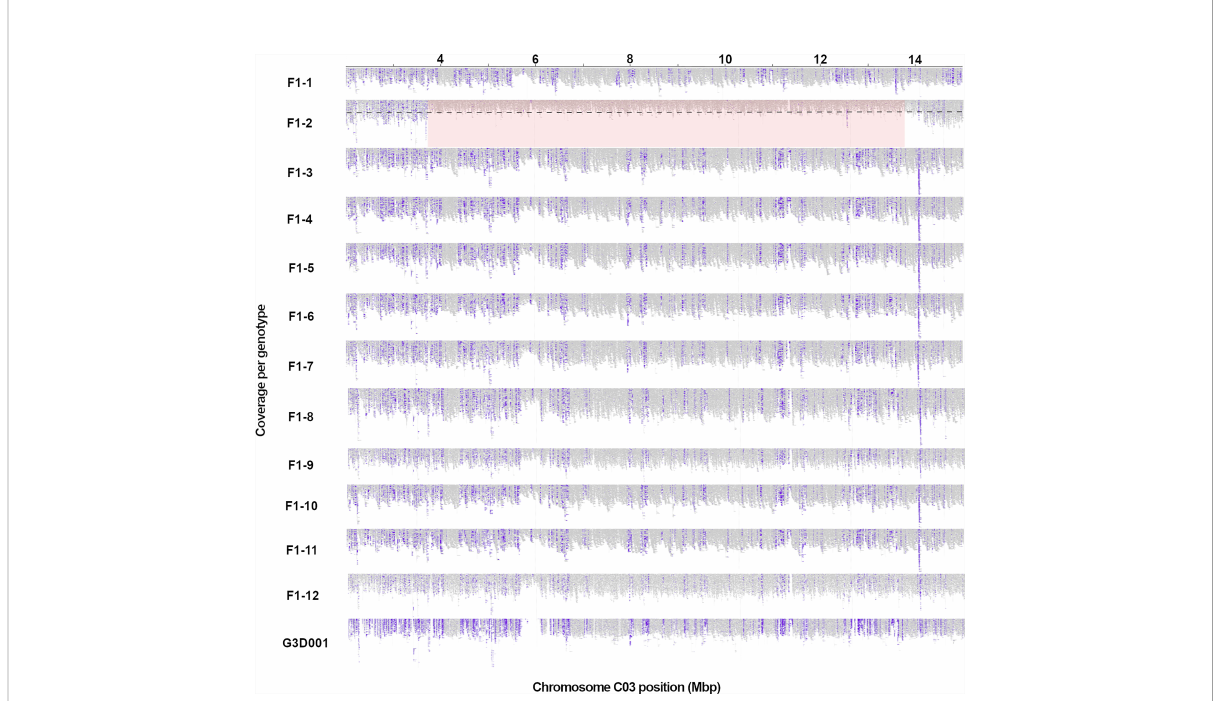
FIGURE 1 A large genomic rearrangement detected on B. napus chromosome C03 in a single F1 plant, F1-2, using Express 617 (Lee et al., 2020) as reference. Long read coverage is displayed from position 2 to 15 in Mbp using the Integrative Genomics Viewer (IGV). Purple blocks represent insertions larger than 30 bp compared to the reference assembly, as detected by IGV; as expected these are highly consistent across the 12 sister F1 plants with the exception of the segmentally deleted region in sister plant F1-2 . The large structural rearrangement (> 1 Mbp) is highlighted in red, with a decrease in read coverage by half (as expected in a segmental deletion) represented by the black dashed line. F1 sample numbers correspond to the 12 biological replicates represented by a single F1 plant